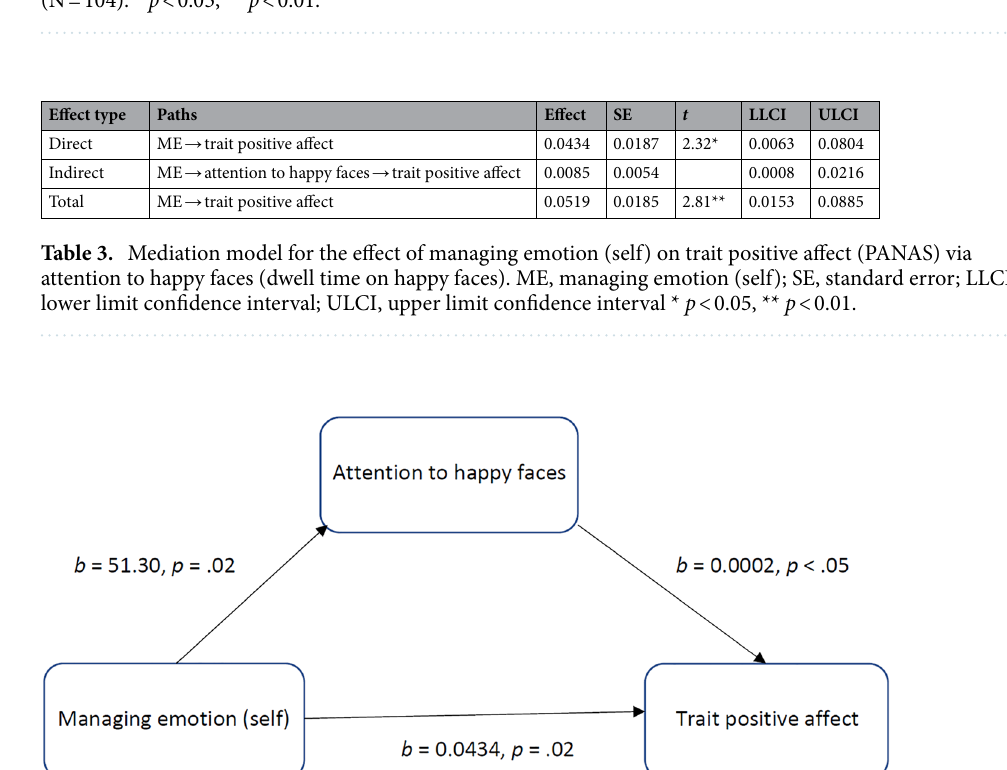
Table 2. Correlations of sustained attention to facial expressions with facets of emotional intelligence (SREIS), state and trait affectivity (PANAS), trait anxiety (STAI), depression (BDI-II), and verbal intelligence (MWT-B) (N = 104). * p < 0.05, ** p < 0.01.